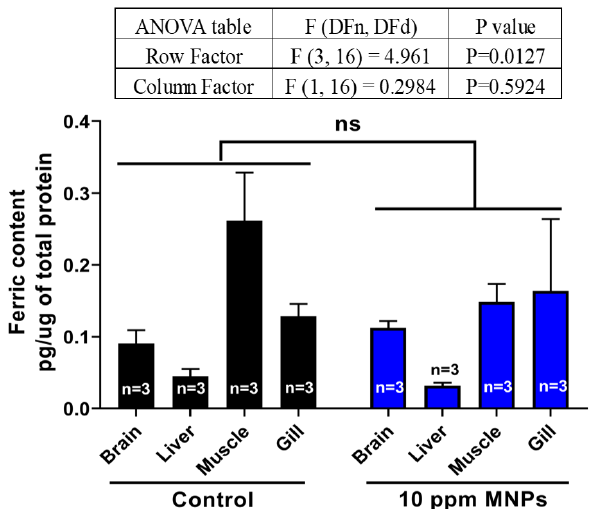
Figure A1. Comparison of ferric content among diverse tissues of brain, liver, muscle, and gill between the control and 10 ppm Fe 3 O 4 MNPs exposed zebrafish. The ferric content in tissue was measured by the colorimetric method and normalized by total soluble protein content. The data are expressed as the mean ± S.E.M. and significance was tested by two-way ANOVA for multiple comparisons. The F factor and P value were also highlighted in the top panel to show the significance level. For each tissue, triplicates were given for ferric content measurement.